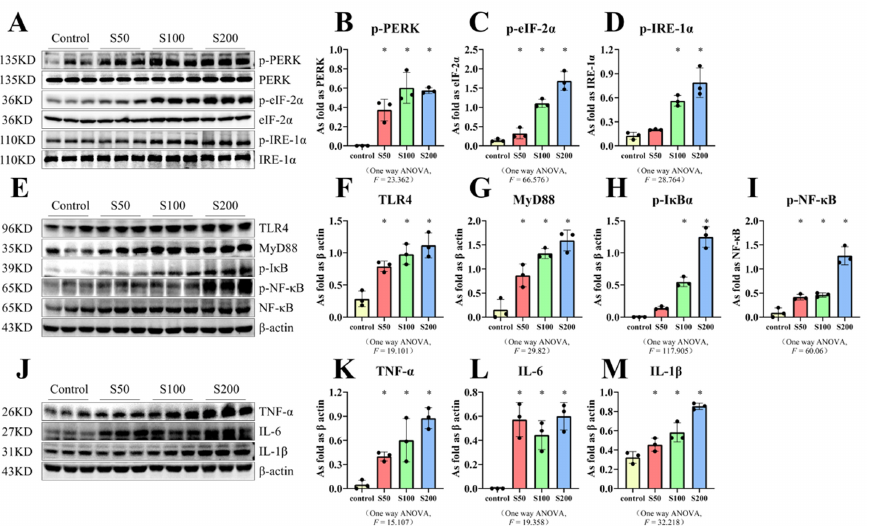
Figure 5. Silica activated the ER stress, TLR4-NF- κ B pathway as well as inflammatory response in macrophages. ( A – M ) Expression levels of p-PERK, p-eIF-2 α , p-IRE-1 α , TLR4, MyD88, p-I κ B α , p-NF- κ B, TNF- α , IL-6, and IL-1 β in MH-S cells treated with SiO 2 at different doses measured by Western blot. * Compared with control group, p < 0.05. Data are presented as the mean ± SD, n = 3 per group.